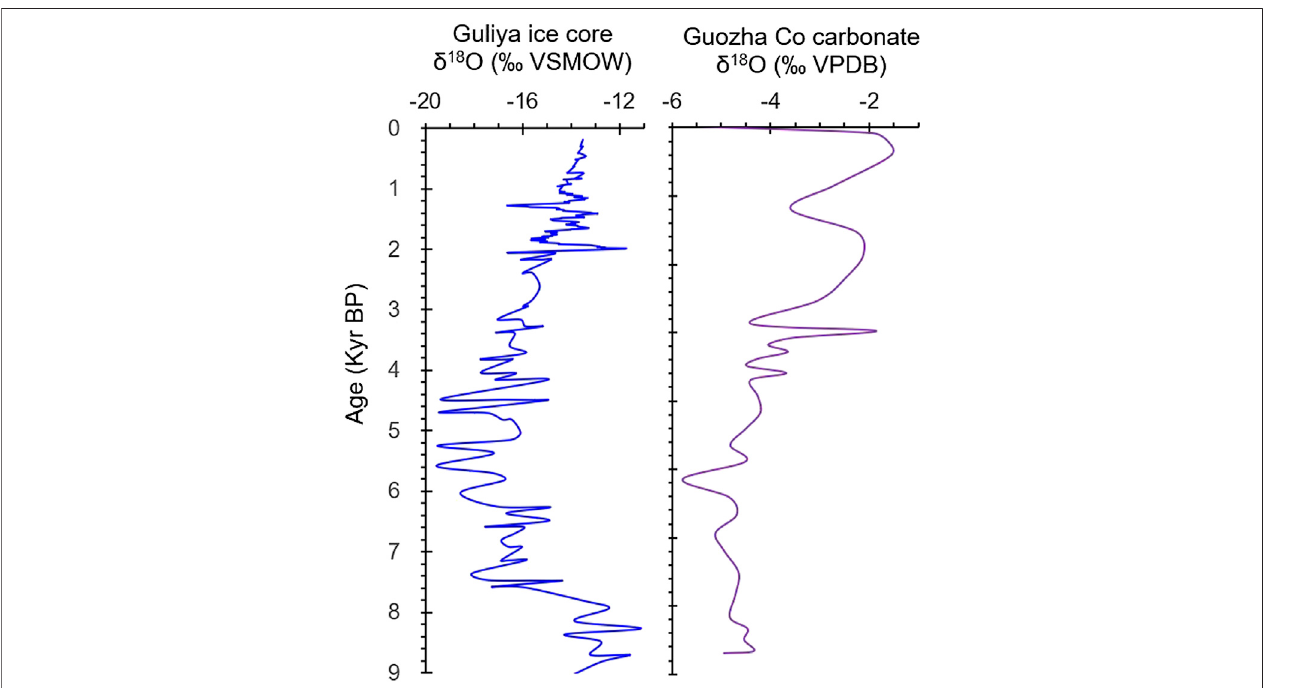
FIGURE 7 | Comparison of the oxygen isotopic compositions of the carbonates in core GZLC15-1 and the Guliya ice core. The δ 18 O data for the ice core are from Yang et al. (2006) and Thompson et al. (2018).